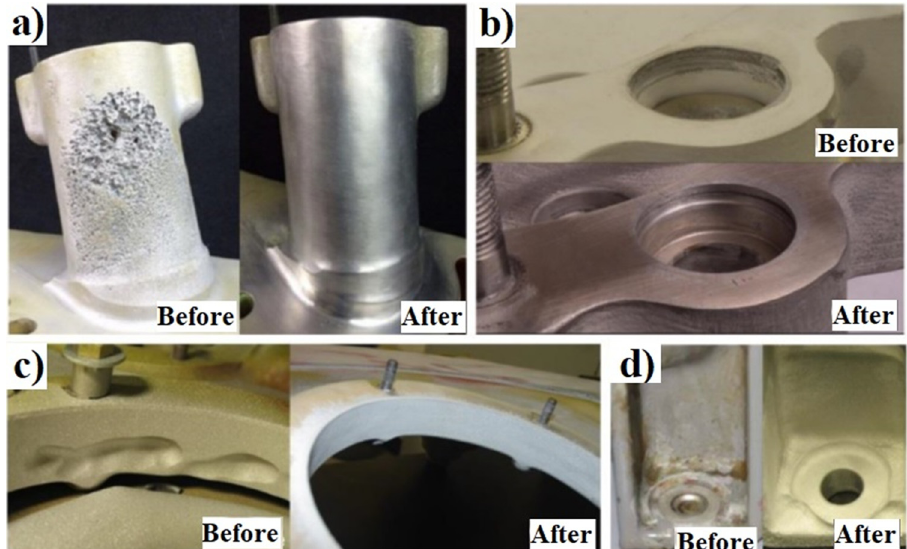
Figure 17: Comparing the deteriorated and restored parts by CSAM: ( a ) S - 92 helicopter gearbox sump; ( b ) oil tube bores in CH47 helicopter accessory cover; ( c ) UH - 60 helicopter gearbox sump; and ( d ) UH - 60 rotor transmission housing [ 68 ]